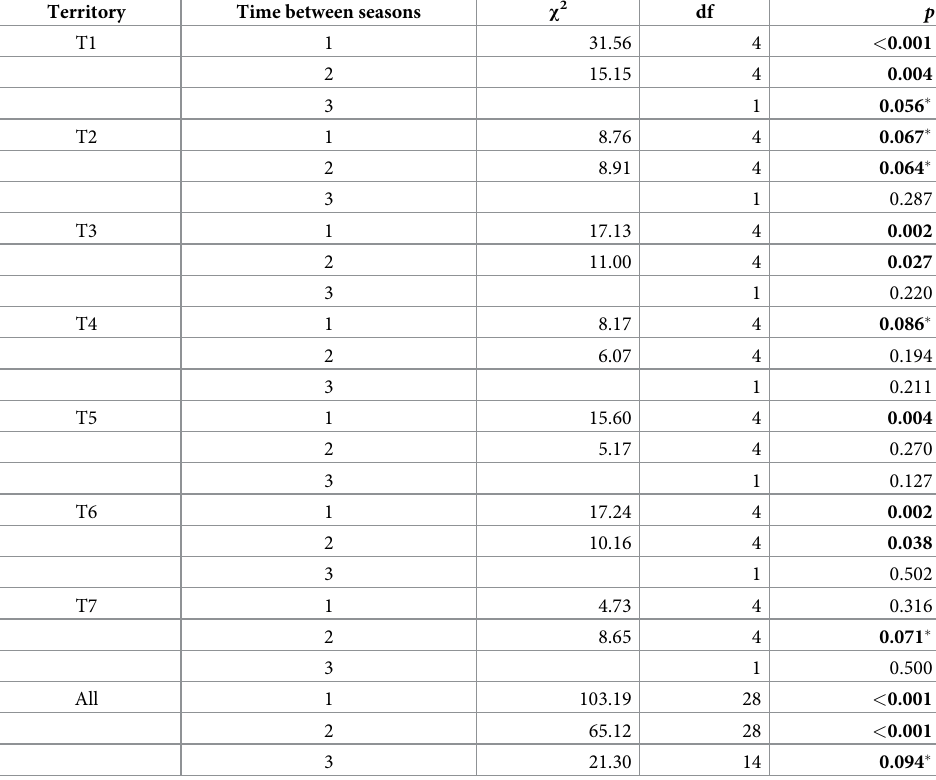
Dietz- R Mantel test p- values were combined by Fisher’s Omnibus Test. The time between seasons indicates how close in time the compared surveys were: 1 = consecutive, 2 = gap of one season and 3 = gap of 2 seasons. Significant values ( p < 0.05) and those close to significance (0.1 > p > 0.05, marked with � ) are shown in bold.